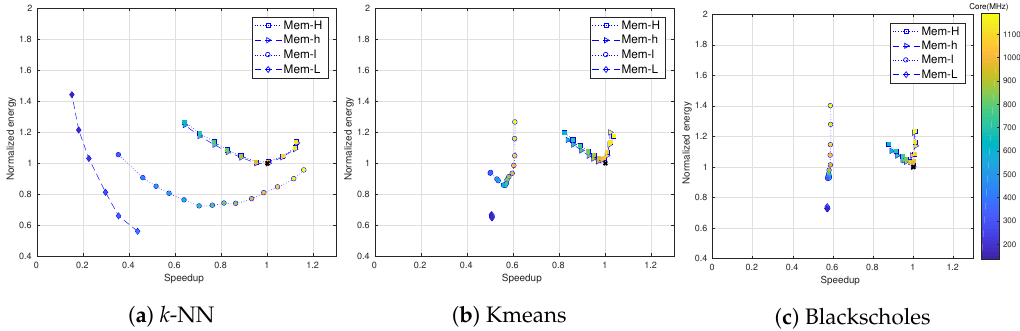
Figure 1. Speedup and normalized energy for three selected benchmarks and different frequency configurations. Toward the bottom (energy) and right-hand side (speedup) is best.